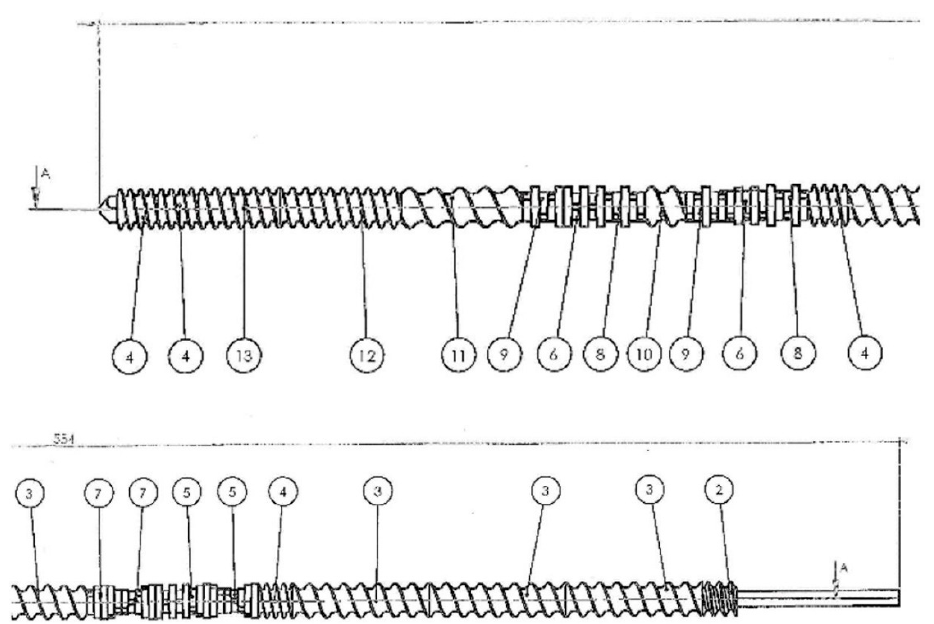
Figure 2. The geometry of the Ø12 screw of a twin-screw extruder with zones: 2—sealing segment; 3, 4, 10, 11, 12, 13—transport segments; 5, 6, 7, 8, 9—grinding segments (Source: [28]). Table 2. The set temperature of the heating zones for the twin-screw extruder. Table 1. Technical data of the ZAMAK REA-2P12A Explorer extruder (based on [28]).